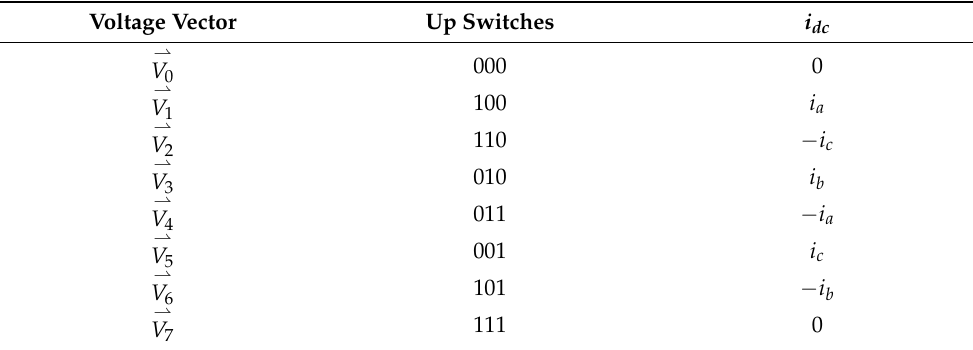
Table 1. The relationship between dc-link current and voltage vectors. Voltage